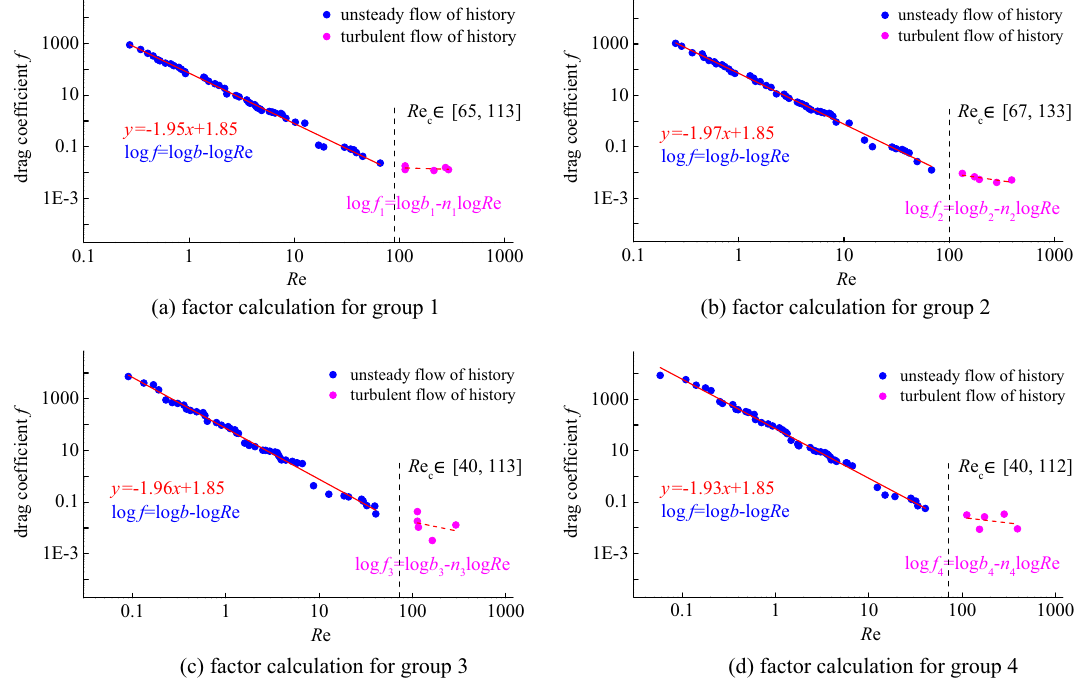
Figure 8. Curve of the resistance coefficient versus the Reynolds